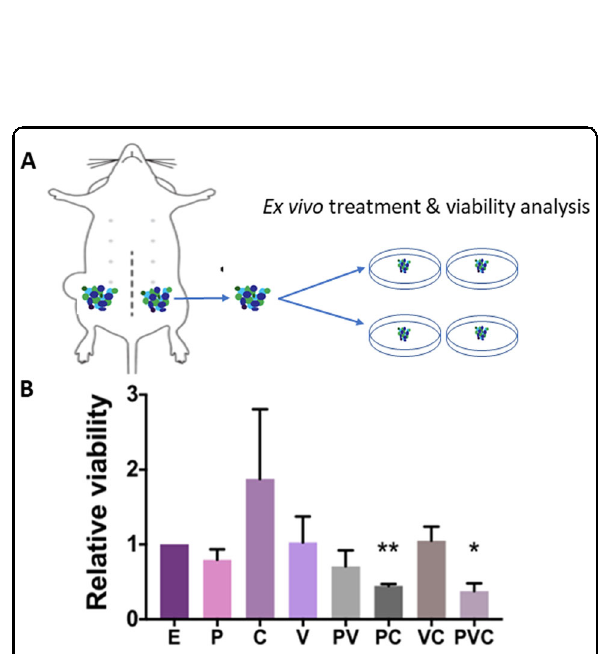
Fig. 5 Combination of vertepor fi n-NP, paclitaxel-NP, and combretastatin-NP decreased ex vivo viability of PDX organotypic slice culture. A , B Ex vivo viability analysis (Almar blue assay) of PDX (HCI-001) organotypic slice culture after 120-hr treatment with E-NP (empty-NP), P-NP (paclitaxel-NP, 5 nM), V-NP (vertepor fi n-NP, 250 nM), C-NP (combretastatin-NP, 5 nM), or different combinations. Data represents means ± SEM, n = 3, * P < 0.05, ** P < 0.01.